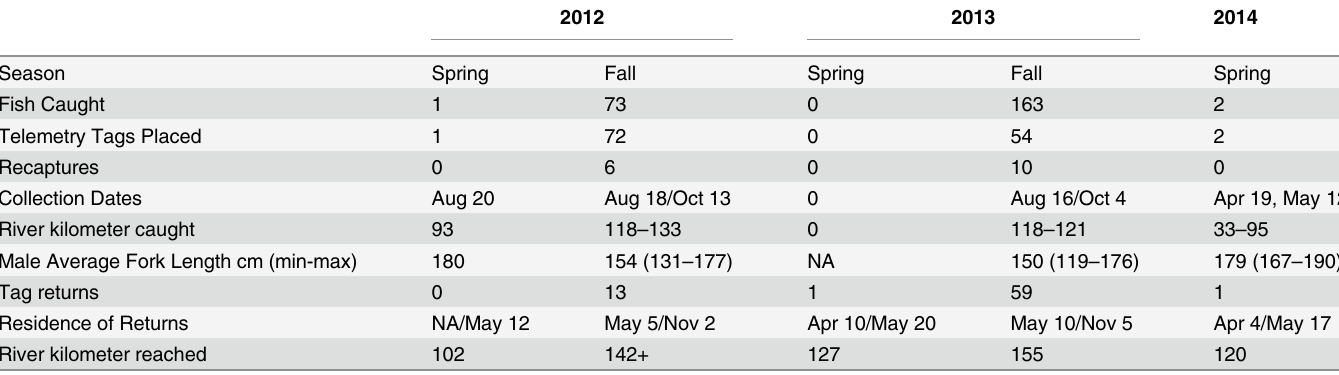
Table 1. Comparison of spring and fall Atlantic Sturgeon collections in the James River from 2012 through the spring of 2014.